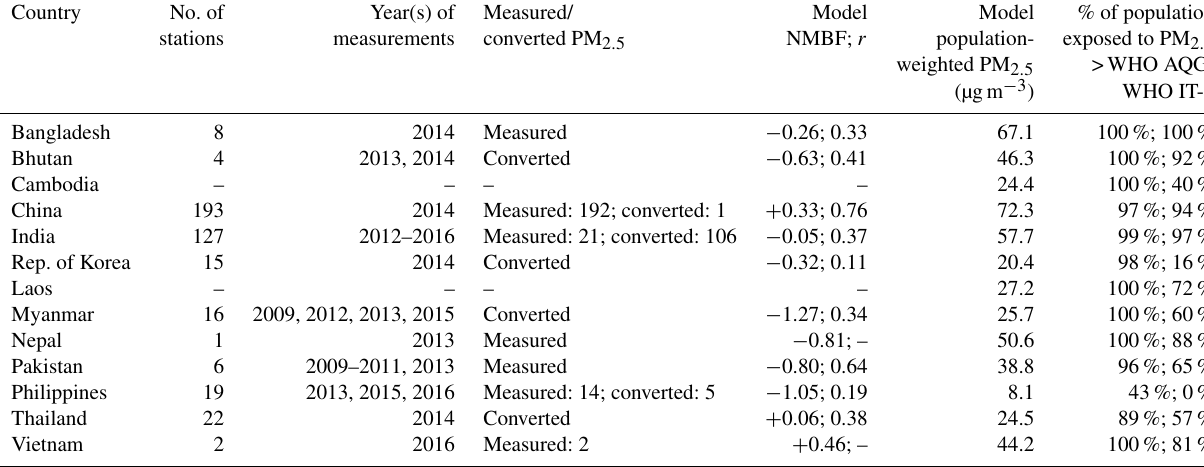
Table 1. Summary of annual mean PM 2 . 5 measurements from the World Health Organization (WHO) Ambient (outdoor) air quality database (2016, 2018). The table shows the number of stations with available data, the year(s) the measurements were conducted, and the number of reported PM 2 . 5 concentrations that were converted from PM 10 measurements (see Sect. 2.3.1). The model normalized mean bias factor (NMBF; Yu et al., 2006) and Pearson’s correlation coefficient ( r ) against observations are given for each country with available WHO measurements. The simulated population-weighted annual mean PM 2 . 5 concentration is given for each country within the model do- main (shown in Fig. 1) and the percentage of population “exposed to” (in the same model grid cell as) annual mean PM 2 . 5 concentrations greater than the WHO Air Quality Guideline (AQG; 10µgm − 3 ) and WHO Interim Target 2 (IT-2; 25µgm − 3 ) (WHO, 2006, 2016). Country No. of Year(s) of Measured/ Model Model % of population stations measurements converted PM 2 .